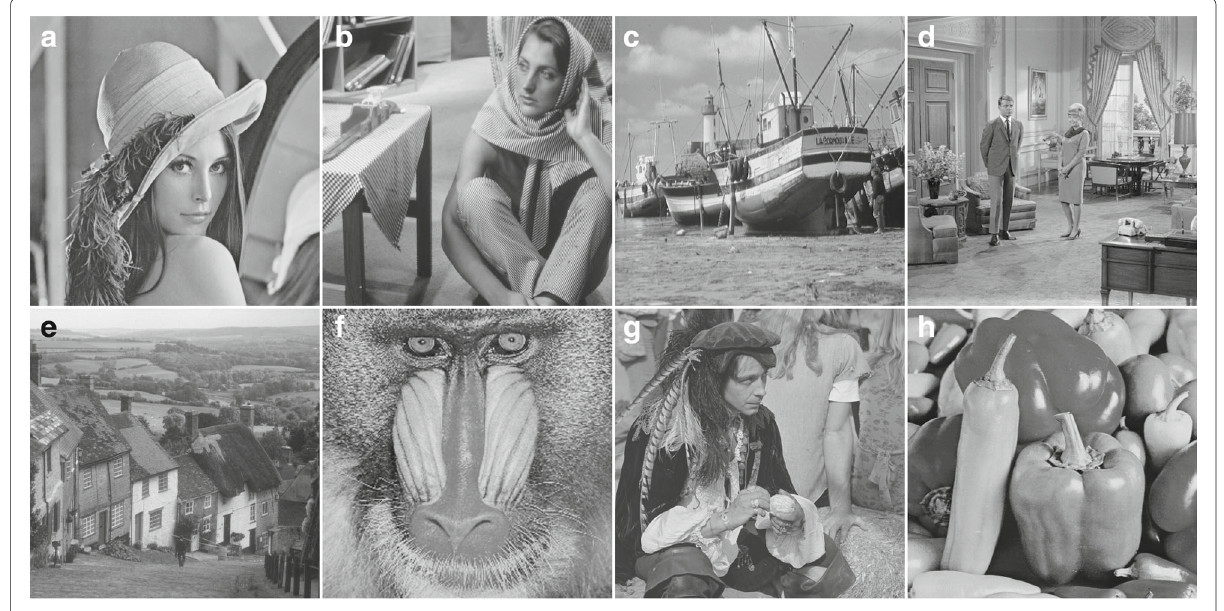
Fig. 3 Test image set: a Lena, b Barbara, c Boat, d Living room, e Goldhill, f Baboon, g Pirate, and h